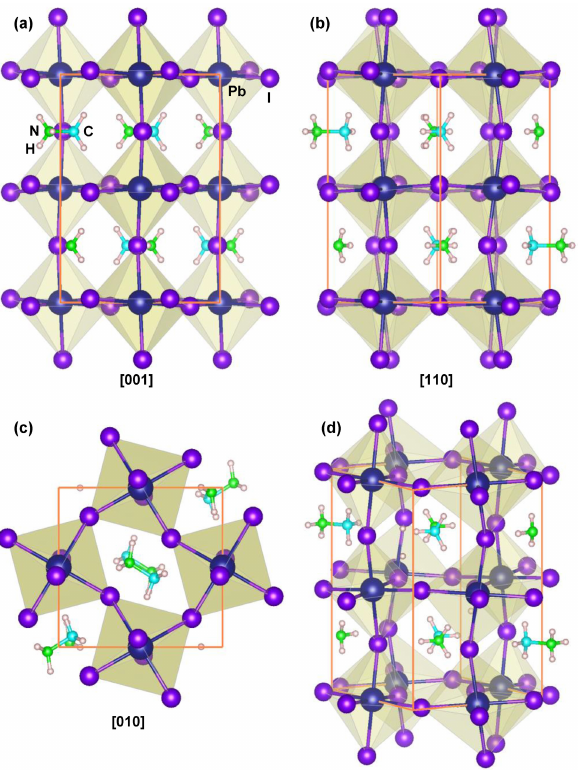
Figure 10: Calculated X-ray diffraction patterns of CH 3 NH 3 PbI 3 with cubic, tetragonal and orthorhombic